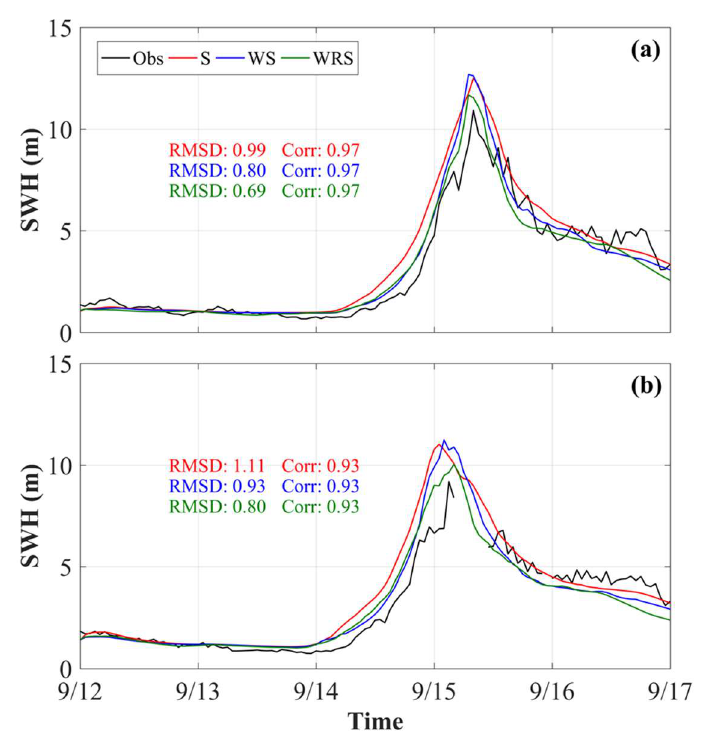
Figure 17. Comparison between observed and simulated significant wave height (m) at ( a ) Buoy 1; and ( b ) Buoy 4. Observation (black), S (red), WS (blue) and WRS (green). The same colors are used for RMSD and R 2 , which are calculated relative to observation.